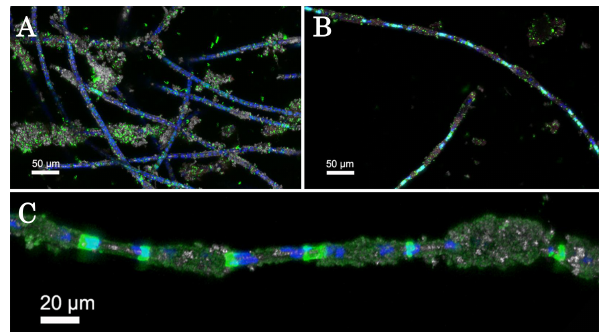
Figure 4. Confocal laser scanning microscopy images of the algae- microbial communities collected at site O (outflow) of the stream in September 2013. Maximum intensity projection of the green algae (a) and the brown algae (b) stained with SYTO ® 9 were recorded (color allocation: green – nucleic acid stain; blue – autofluorescence of chlorophyll a ; grey – reflection). Brown algae stained with AAL- Alexa448 (c) shows glycoconjugates (green), autofluorescence of chlorophyll a (blue), and refection (grey).